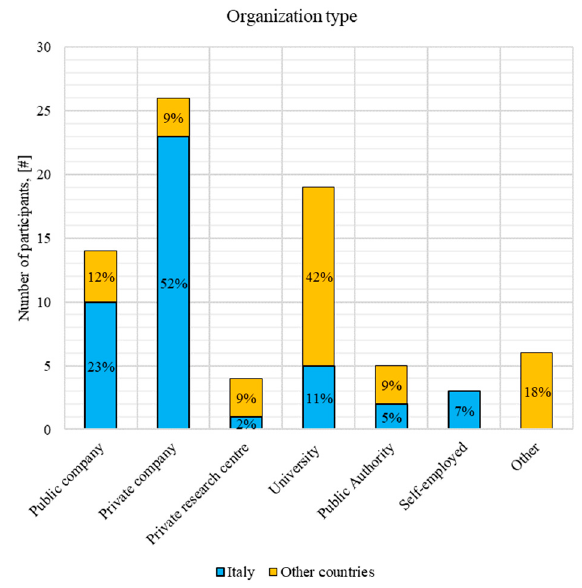
Figure 3. Number of survey participants as a function of the organization type.